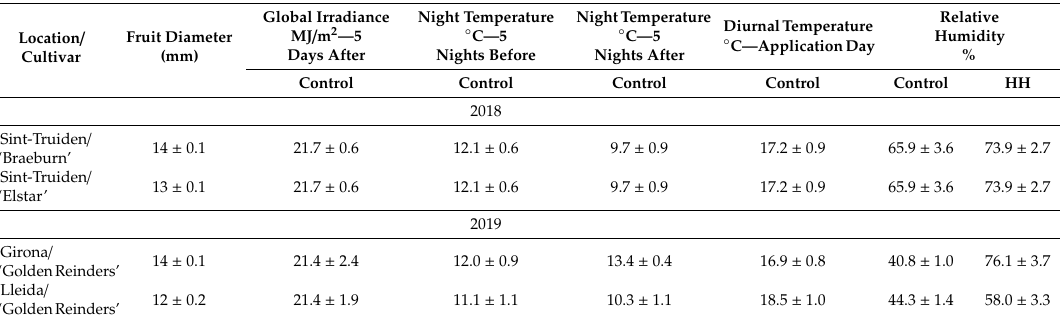
Table 1. Summary of the meteorological conditions in each trial: the cultivar, fruit diameter at the time of metamitron application, average of daily irradiance during 5 days after spraying (DAS) (MJ / m 2 ), average night-time temperature from 20:00 to 8:00 h during 5 nights before and after spraying ( ◦ C), average diurnal temperature from 8:00 to 20:00 h on the spraying day ( ◦ C), and average air relative humidity during the 3 h prior spraying (%) in environmental conditions (Control) and high relative humidity conditions